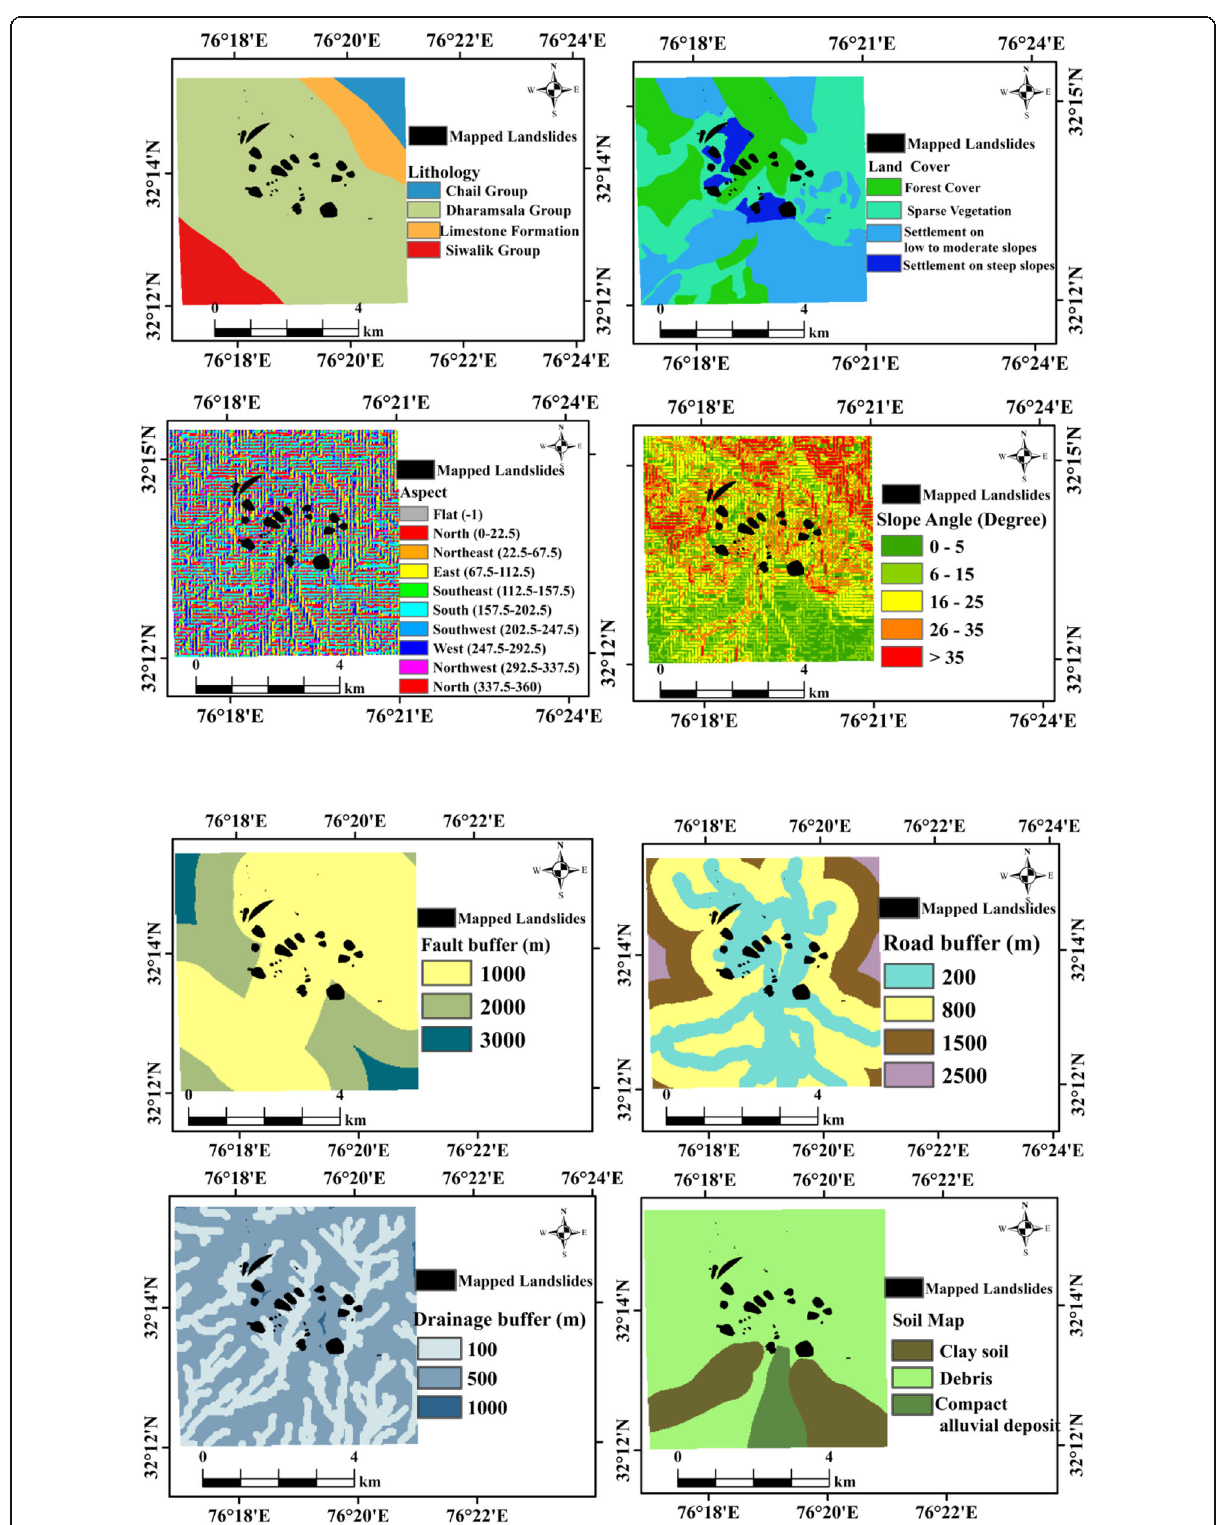
Fig. 5 Maps of the chosen causal factors (1) Lithology (2) Land cover (3) Aspect (4) Slope (5) Fault buffer (6) Road buffer (7) Drainage buffer (8) Soil